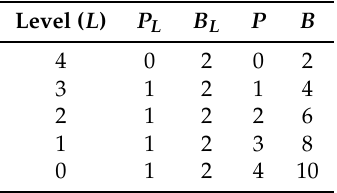
Table A1. Numbers of pooling and convolution operations; P L and B L denote numbers of pooling and convolution operations at level L , respectively; P and B denote cumulative numbers of pooling and convolution operations, respectively.